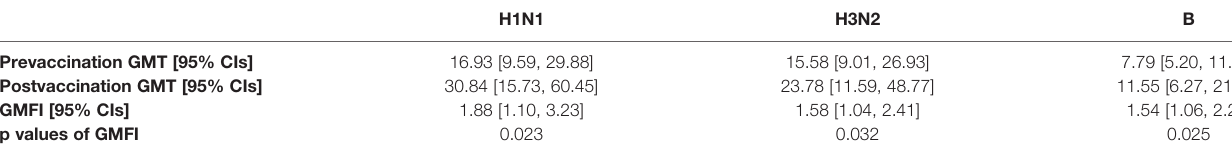
† ‡ and seroconversion by virus